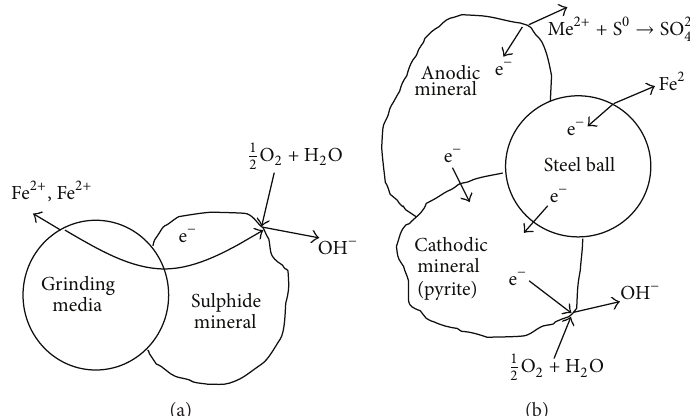
Figure 4: Model galvanic interactions between a single sulphide mineral (a) [31] and two sulphide minerals (b) [33] and steel ball during grinding.